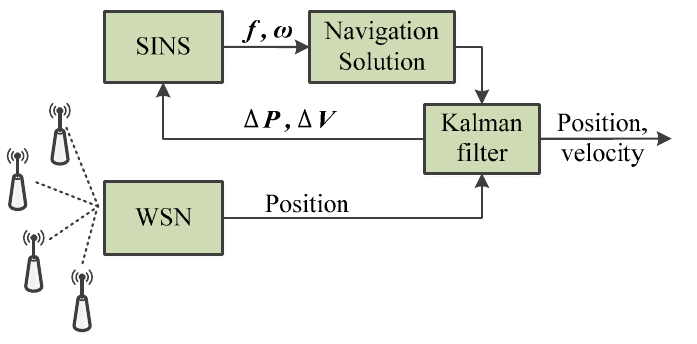
Figure 1. Structure of loosely-coupled integration model.